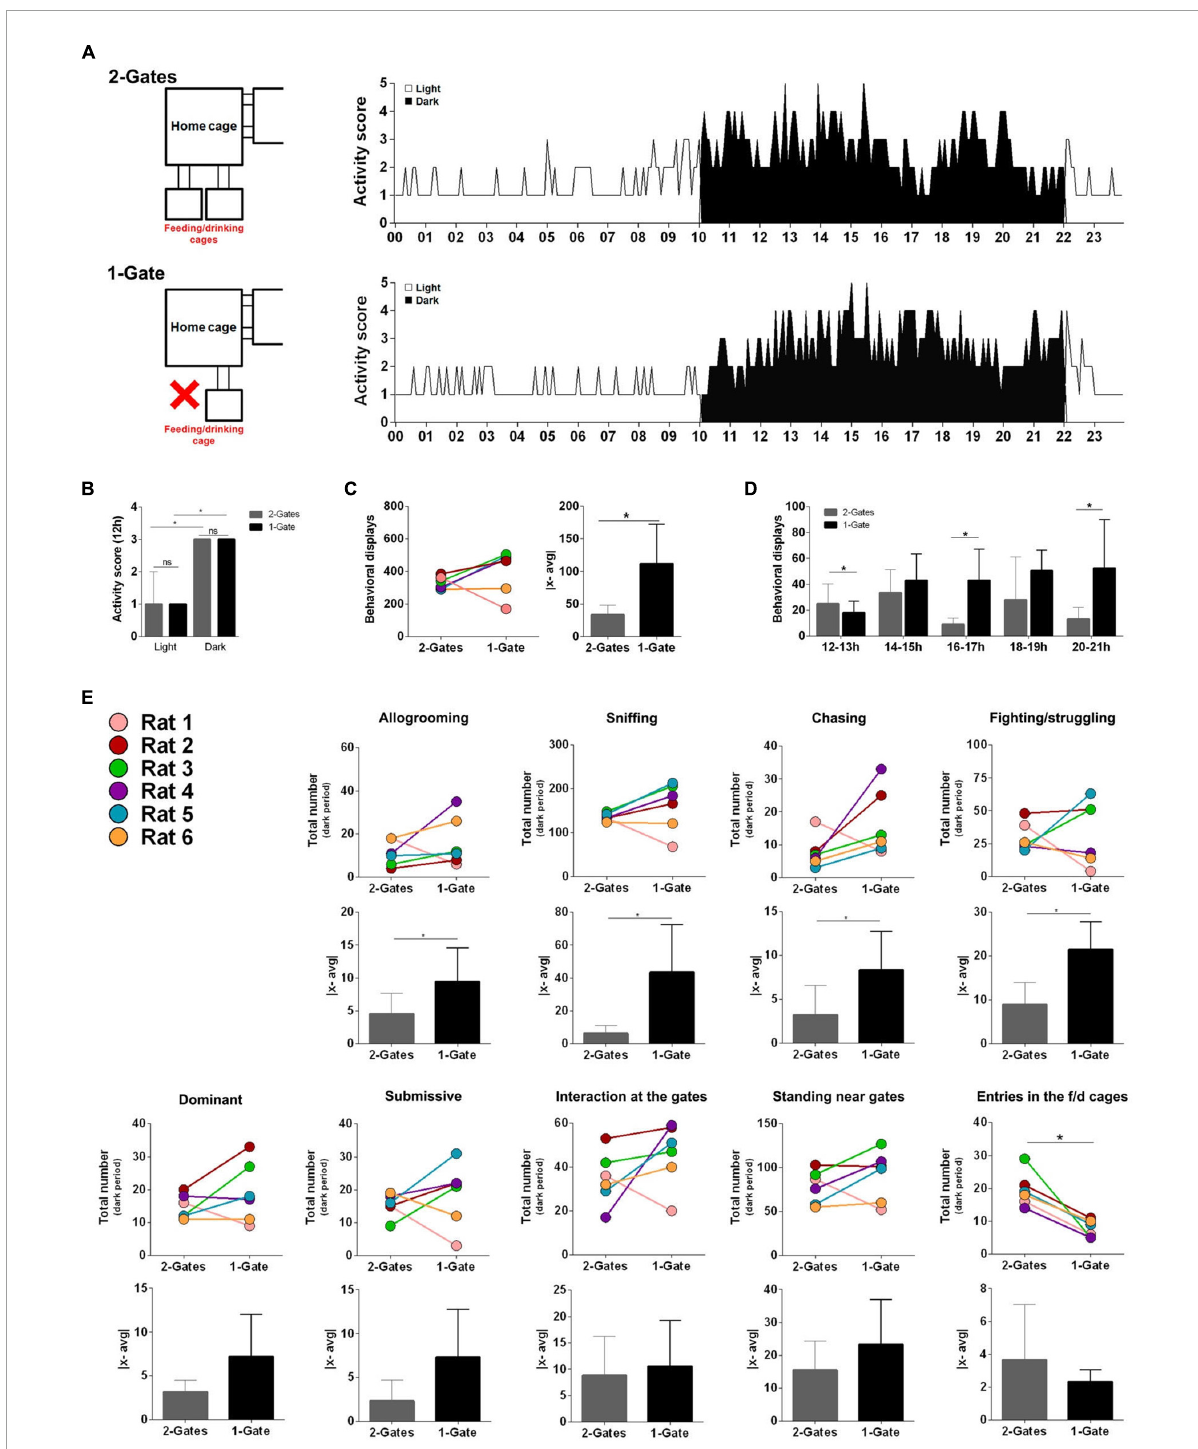
FIGURE1 Activity in the home cage: 2- and 1-gate conditions. (A) Representative graphs of the activity of the six rats, in the home cage, in the 2- and 1-Gate paradigm. (B) Results of activity scores in the central cage were similar in the 2- and 1-Gate experiments; scores were significantly higher in the dark period. Results are presented as median and IQR; n = 144 scores/group, Wilcoxon test. (C,D) Access reduction to food significantly increased the number of behavioral displays (particularly evident in the later phases of the dark period), as well as the dispersion within the group. (E) 2- to 1-Gate transition significantly increased within group variability in allogrooming, sniffing, chasing and fighting/struggling. Results are presented as median and IQR; n = 6/group, * p < 0.05, Wilcoxon